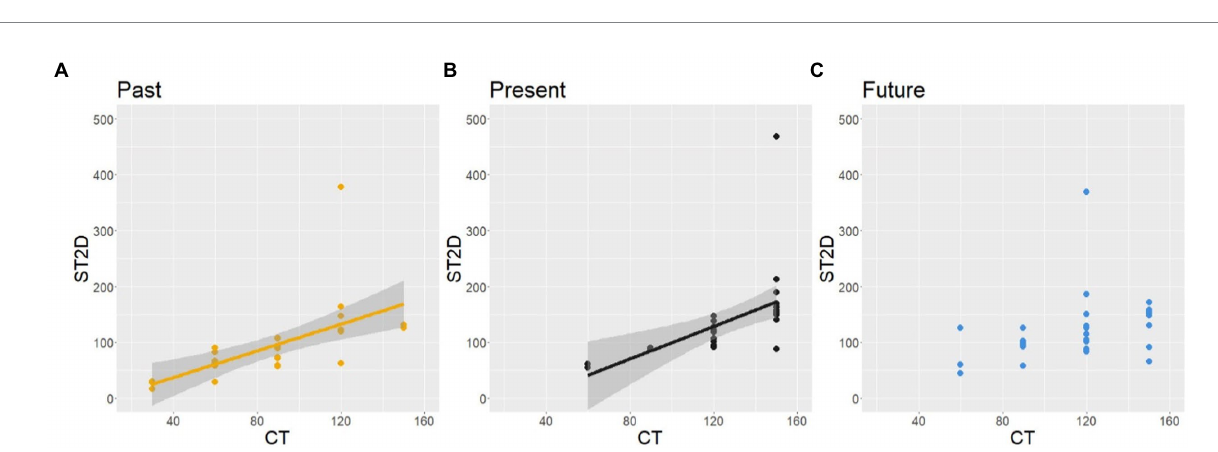
FIGURE 3 Sizes of spheres in ST on the screen as a function of the sizes of circles in CT. Each dot expresses a participant’s results for the past (A) , present (B) , and future (C) . The gray areas surrounding the regression lines indicate the confidence